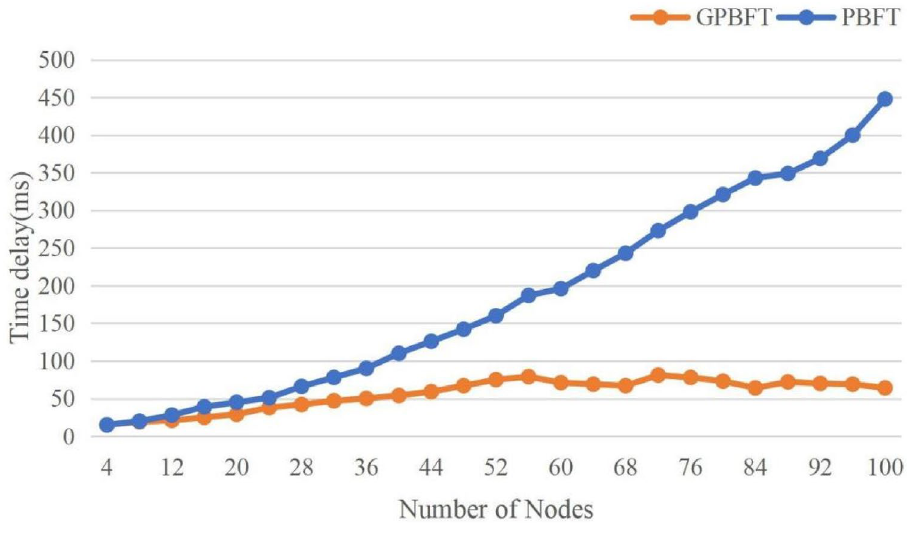
Figure 6. Comparison of consensus